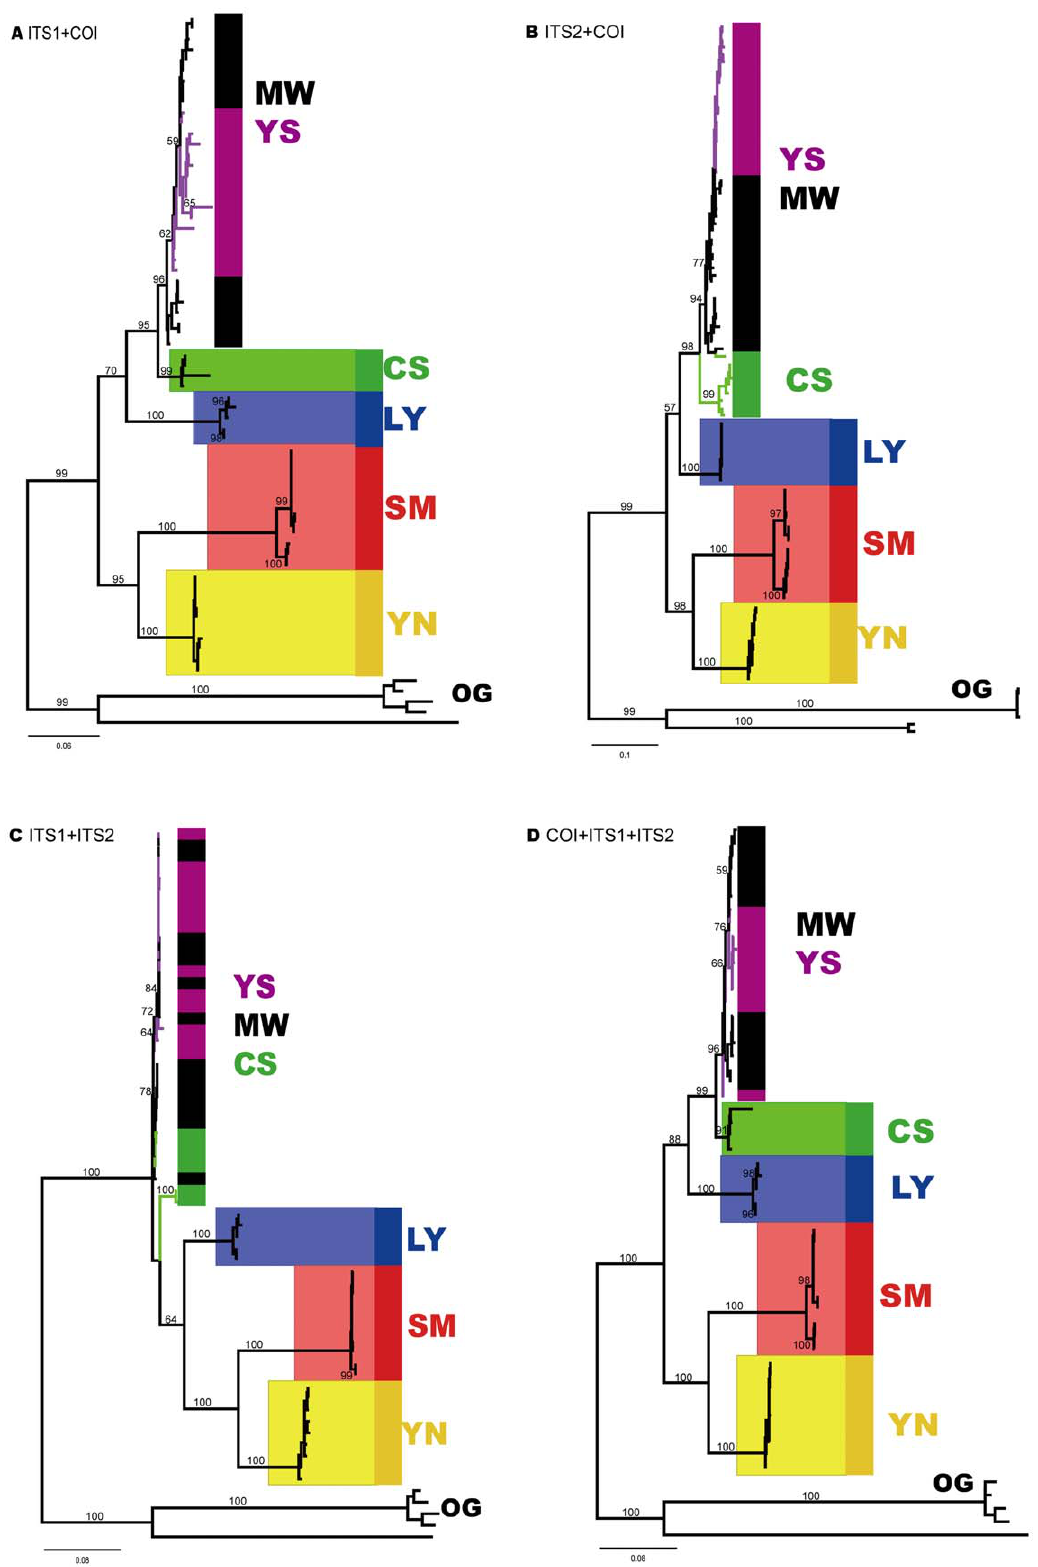
Figure 5. Phylogenetic trees (ML) of six Dendrolimus pine moth species constructed with multiple genes (a combination of two or three COI, ITS and ITS2). A) ML tree based on a combination of COI and ITS1 gene; B) ML tree based on a combination of COI and ITS2 gene; C) ML tree based on a combination of ITS1 and ITS2 gene; D) ML tree based on a combination of COI, ITS1, and ITS2 gene.